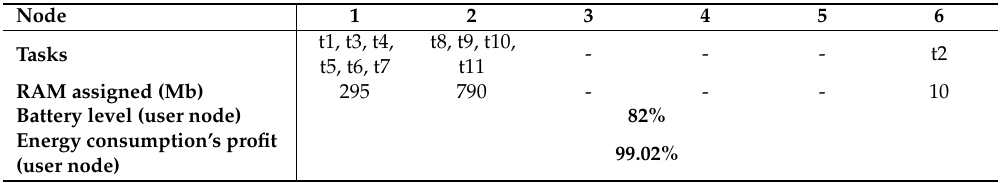
Table 2. Optimal tasks assignation for the problem of Figure